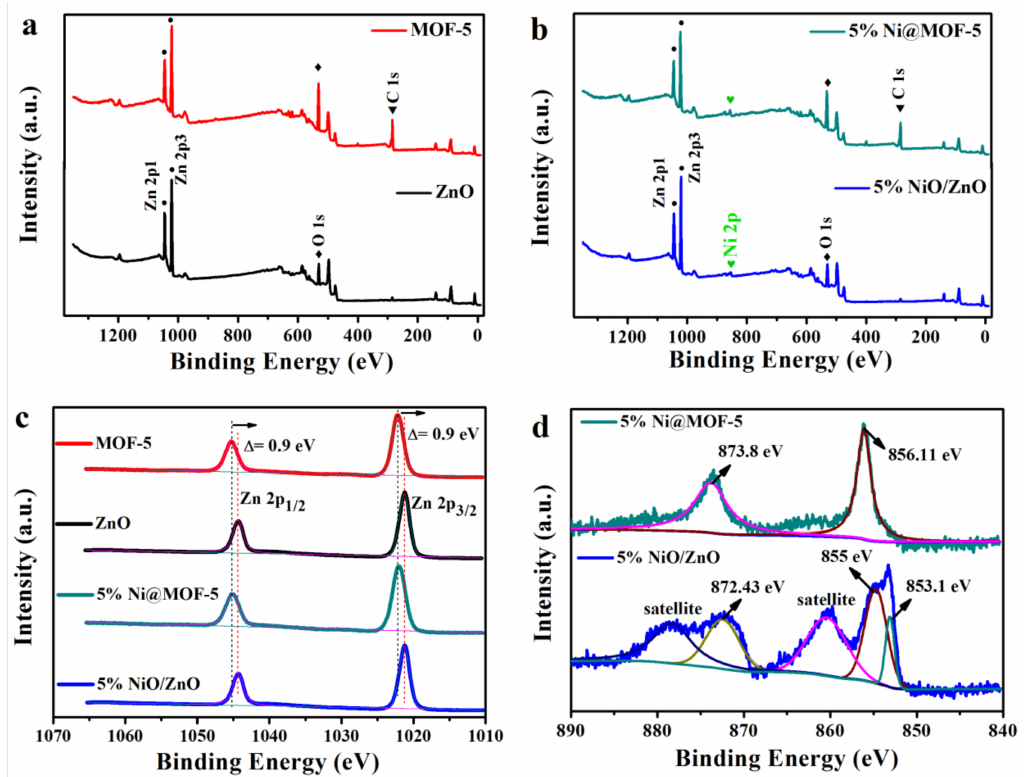
Figure 1. ( a , b ) Full scan spectrum of materials, ( c ) Zn 2p spectrum, and ( d ) Ni 2p